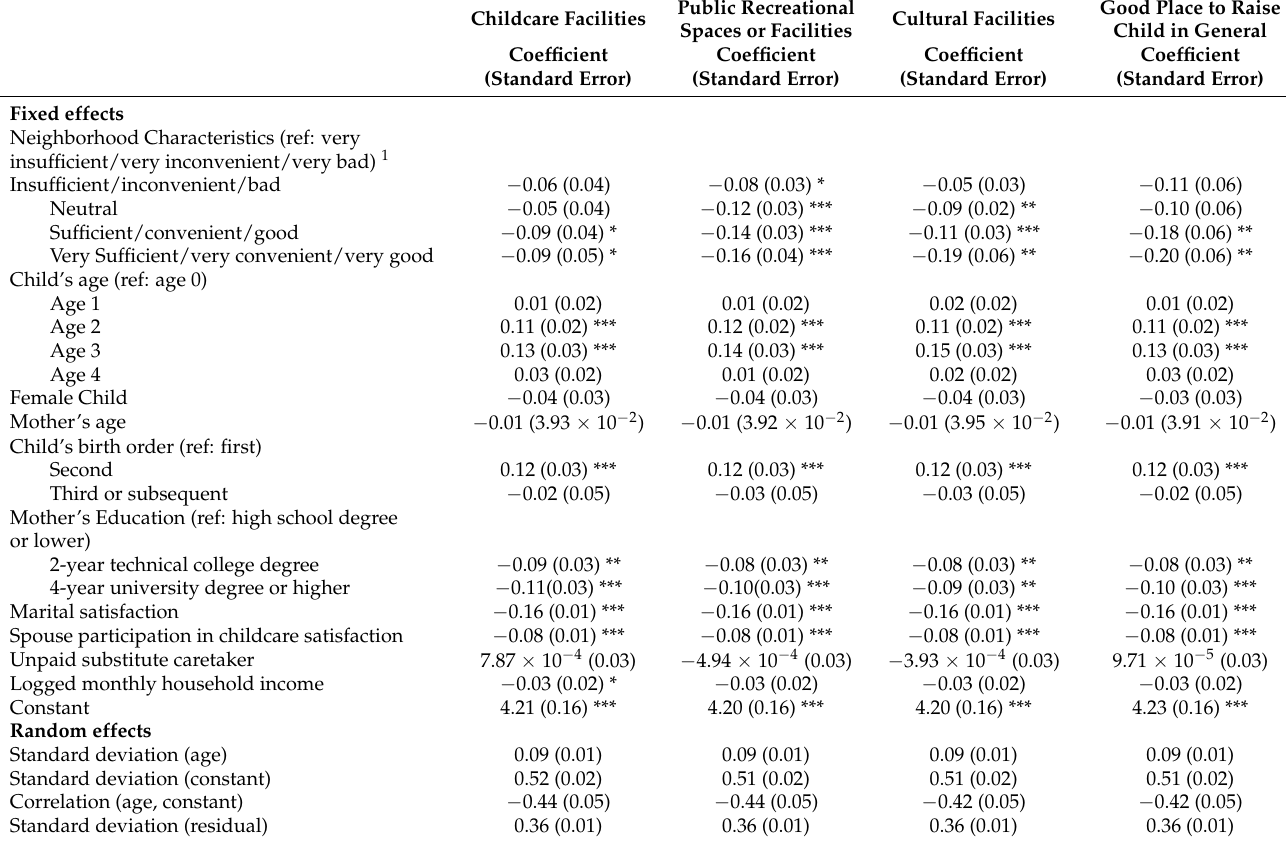
Table 4. Multilevel Mixed Effect Modeling ( n =